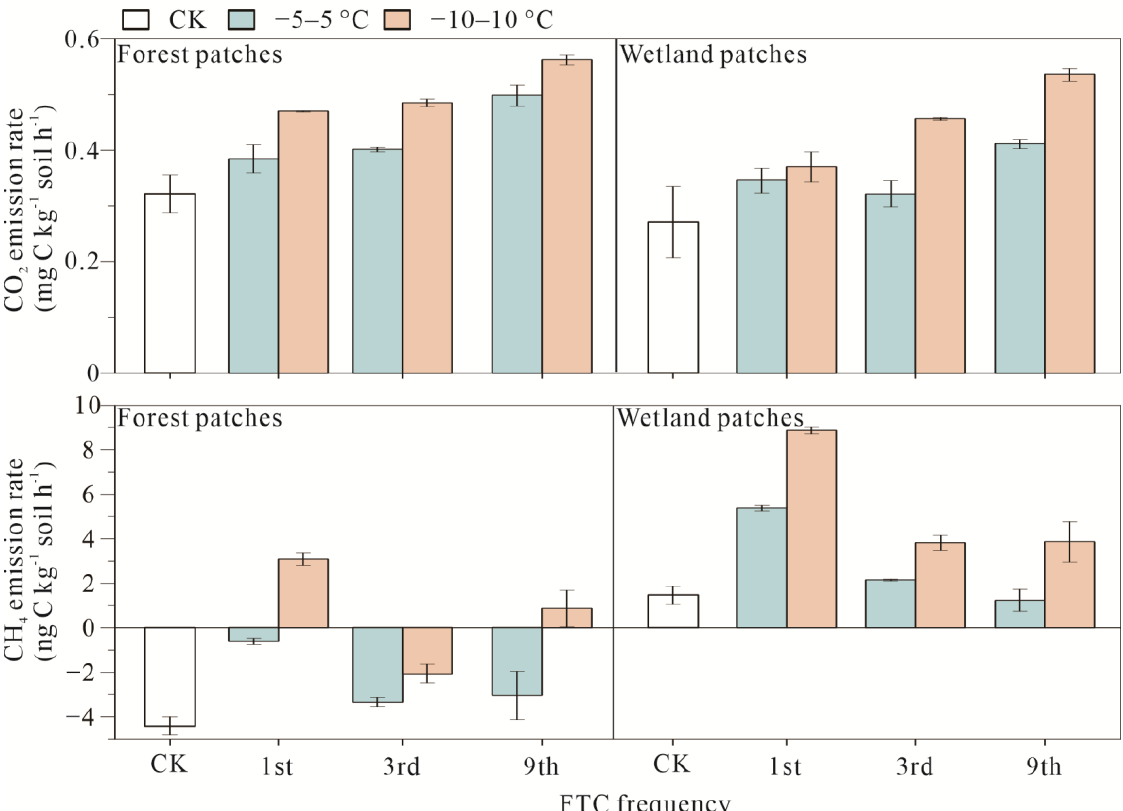
Figure 2. CO 2 and CH 4 emission rates of forest and wetland patches under different